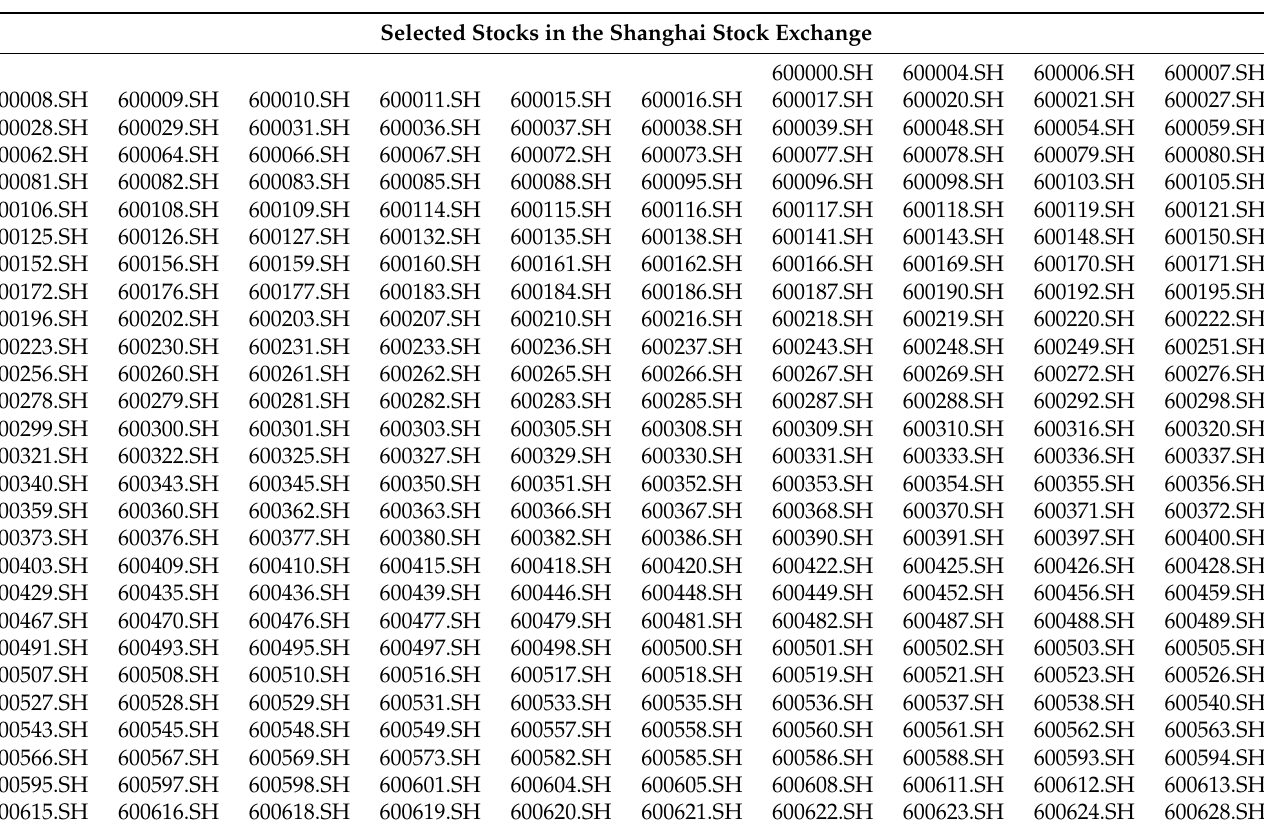
Table A3. Ticker symbol for the 1000 randomly selected stocks in the Shenzhen and Shanghai stock exchanges. This table reports only the stocks traded in the Shanghai